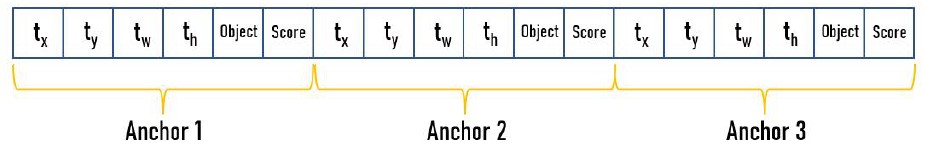
Figure 7. Schematic diagram of the components of the output vector.